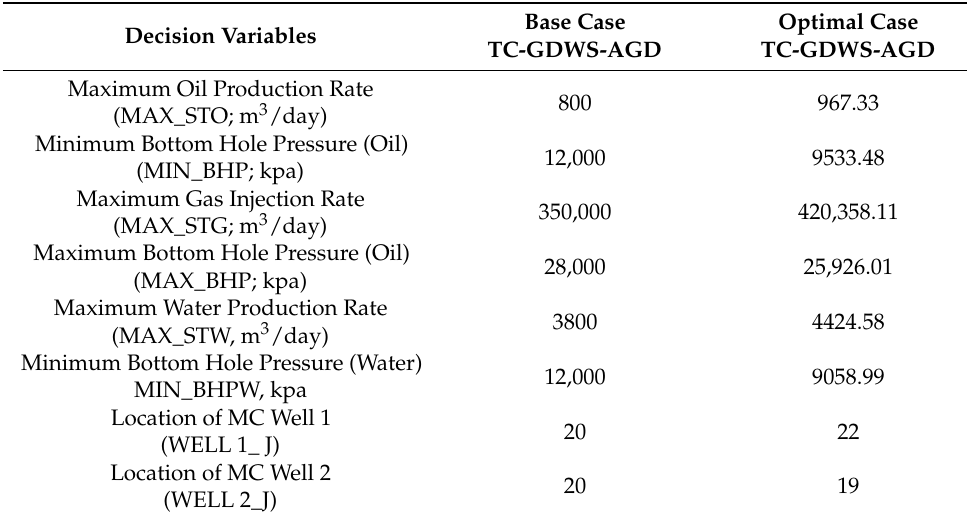
Table 4. Base-case and PSO-derived optimal-case operational decision variable values for the TC- GDWS-AGD simulation of the PUNQ-S3